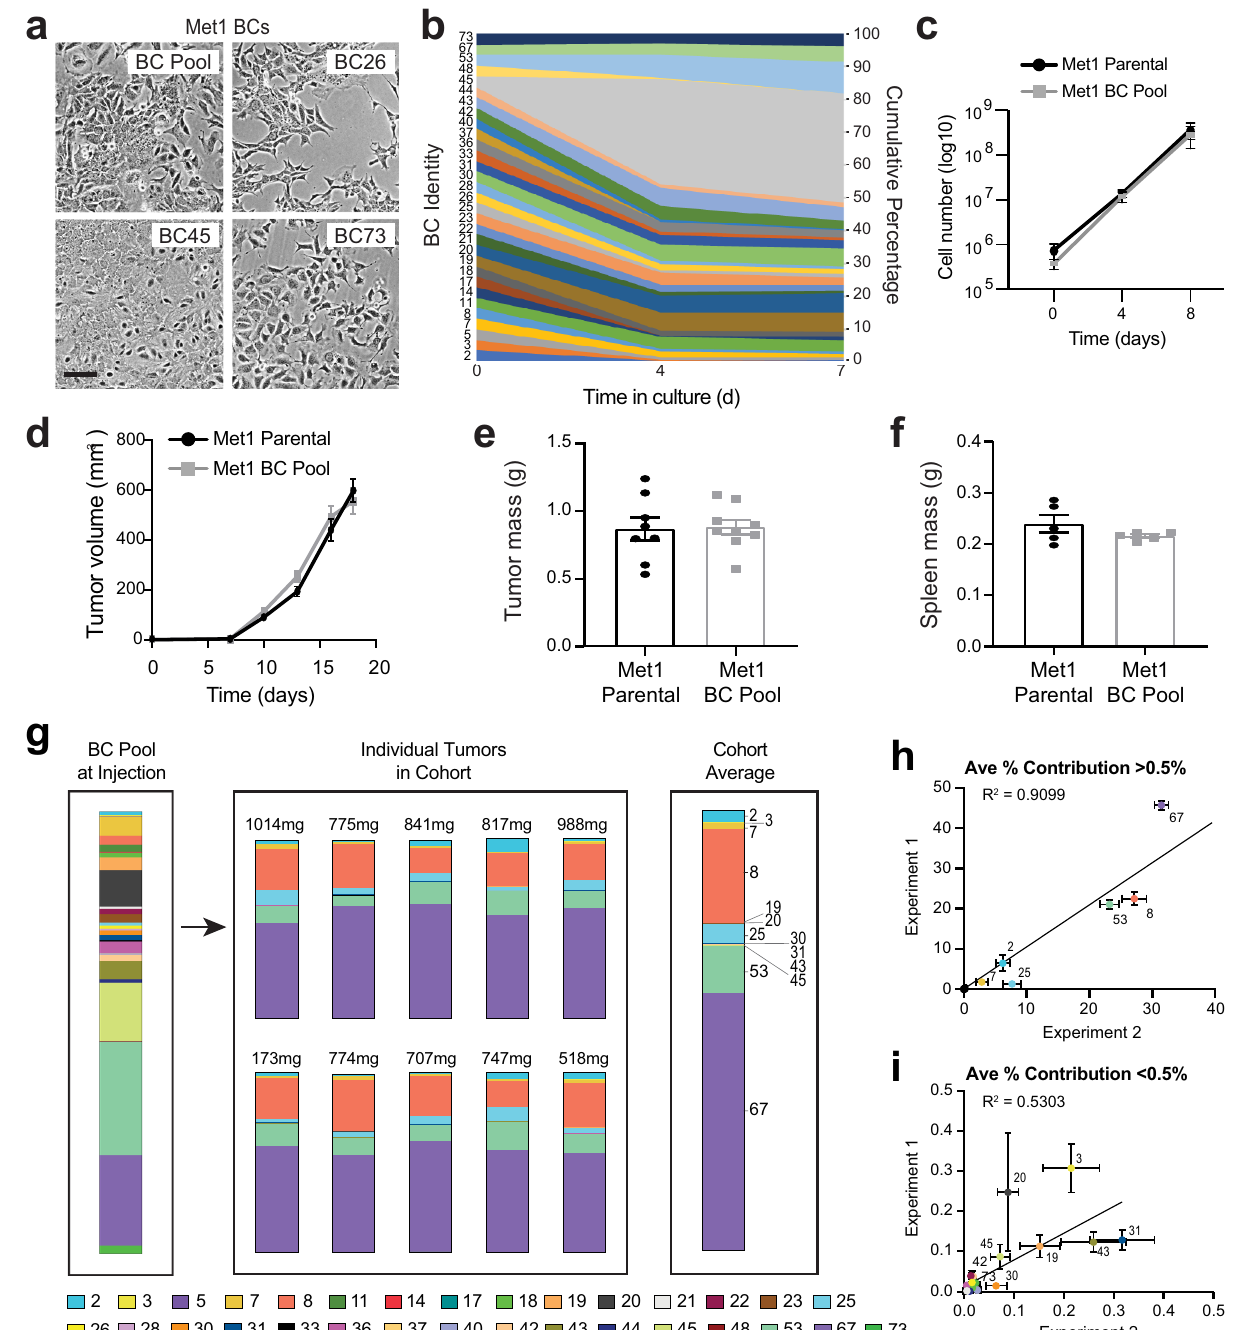
Fig. 3 SunCatcher approach maintains tumorigenic properties and enables analysis of heterogeneity. a Phase contrast images of indicated Met1 BCs; scale bar = 100 μ m. Images are representative of 2 independent observations. b Sand plot showing clonal composition (cumulative percentage) of Met1 BC Pool over 7 days (d) (2 passages) in vitro. c Growth of Met1 Parental (black; Y = 0.3360x + 0.1699) and Met1 BC Pool (gray; Y = 0.3562x + 0.4121) over 8 days in culture; n = 4 replicates per group; data are presented as mean values ± SD. d Growth of tumors from Met1 parental cells ( n = 8 tumors) and Met1 BC Pool cells ( n = 9 tumors) in FVB mice; n = 5 mice per cohort, data are presented as mean values ± SEM. e , f Mass (grams) of tumors ( e ) and spleens ( f ) from mice in experiment represented in ( d ); data are presented as mean values ± SEM. g Quantitative PCR assessment of barcode composition in the Met1 BC Pool at time of injection, in each of ten tumors ( n = 5 mice) after 18 days, and average composition of all tumors in the cohort. Bars show indicated barcodes as a percent of total barcode signal (100%) within each sample; tumor mass is indicated above each bar. Key shows color code for each BC. h , i Comparison of the average representation of each BC in tumors for each of two independent experiments ( n = 8 tumors for experiment 1; n = 6 tumors for experiment 2). BCs that constituted >0.5% of total BC signal ( h ) and <0.5% ( i ). Correlation coeff i cients (R 2 , simple linear regression) are shown; data are presented as mean values ± SEM. Source data are provided as a Source Data fi